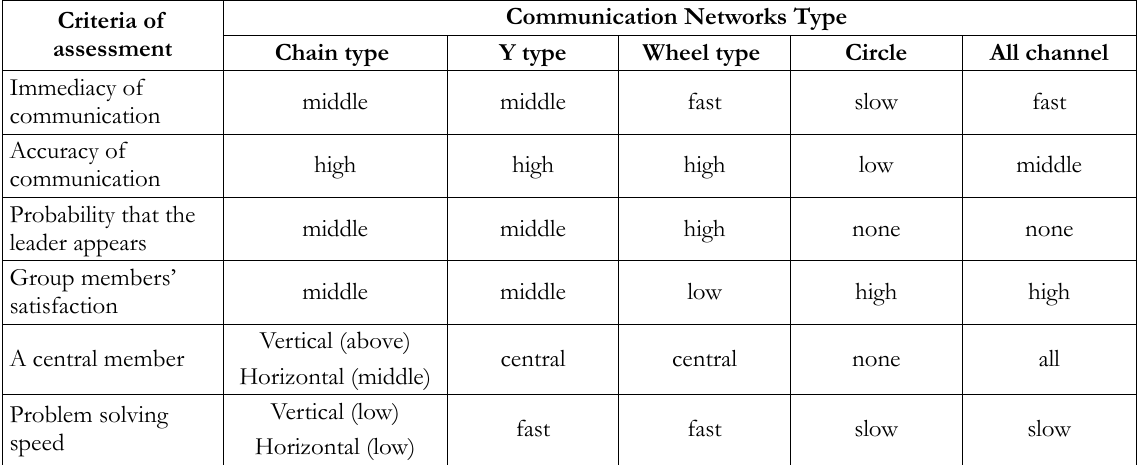
Table 5. Evaluation of Communication Networks (Bavelas & Barrett, 1951)